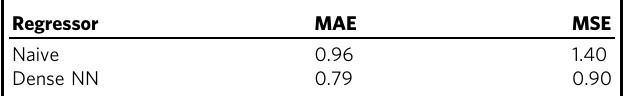
Table 4 OpenReview regression performance vs. naive regressor (the lower the better).